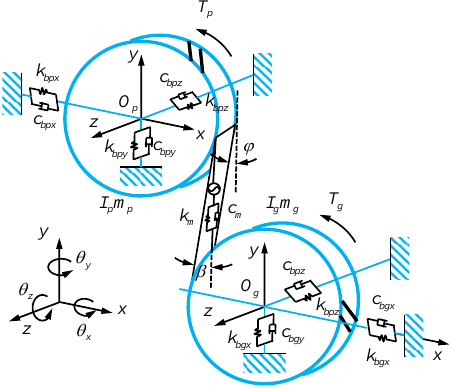
Figure 12. Dynamic model of the electric drive transmission system. In Figure 12, O p and O g are the rotation centers of the driving and driven gears, respectively, with the counterclockwise rotation around the central axis as the positive direction, and the compression spring stiffness direction as the positive direction of the meshing force. The stiffness/mass matrix of the shaft parts is extracted by the lumped-mass method, and the dynamic equations including the movement direction of the driving and driven gears along x , y , and z directions and the rotation direction around the axis of the gear can be established, respectively, as shown in Equations (43) and (44), to study the nonlinear dynamic characteristics of the gear system under different input torques and rotating